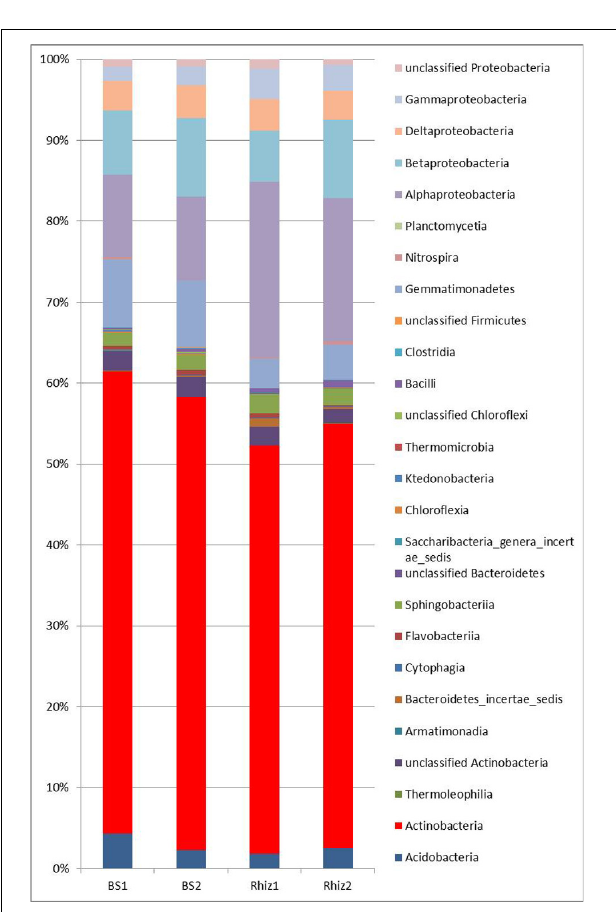
FIGURE 4 | Microbial community composition in the bulk soil and rhizosphere of V. vinifera cv. Pinot Noir at the two sampling times (flowering and early fruiting) at the class